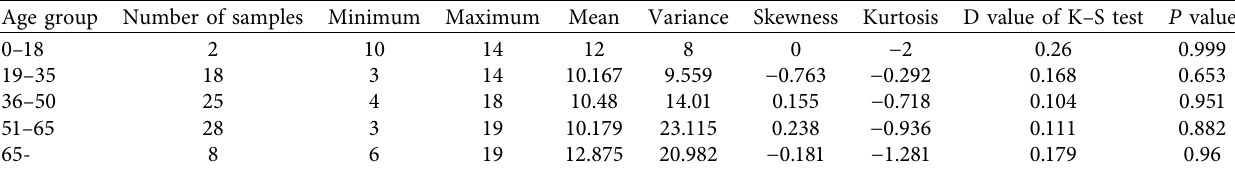
Table 3: Statistical characteristics and normal distribution test of incubation time data in different age